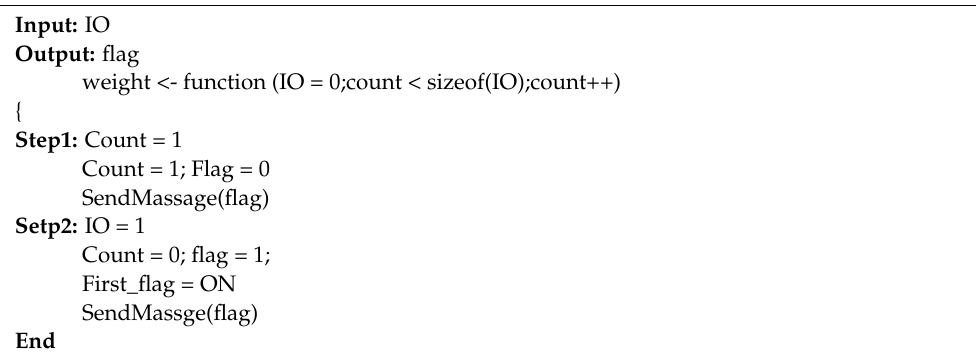
Algorithm 1: Algorithm for turn signal detection method